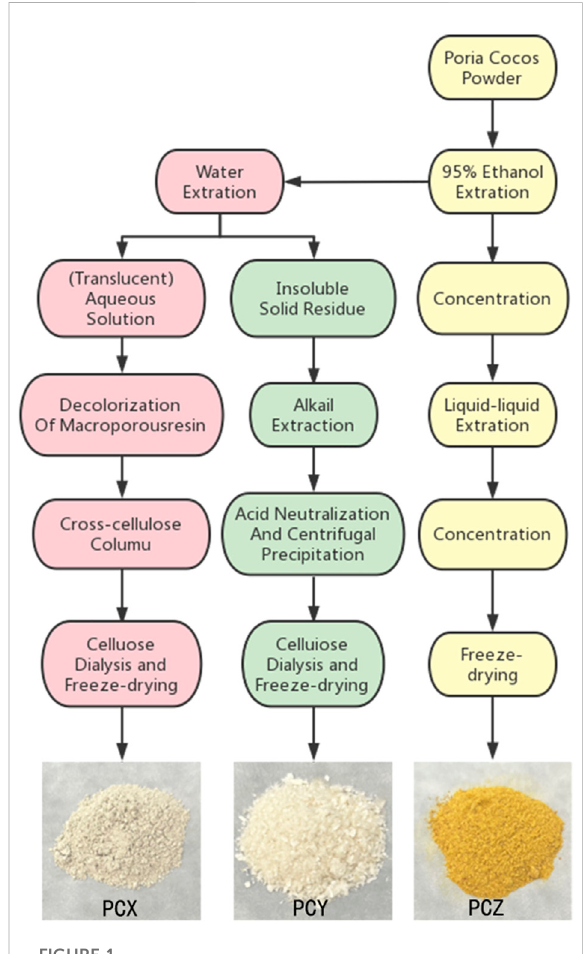
FIGURE 1 Schemes of extraction of three prominent active component fractions from P.